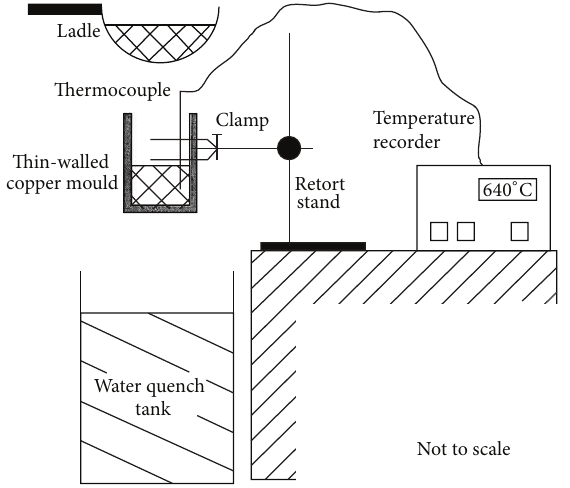
Figure 20: Schematic diagram of experimental procedure of the DTM [46].